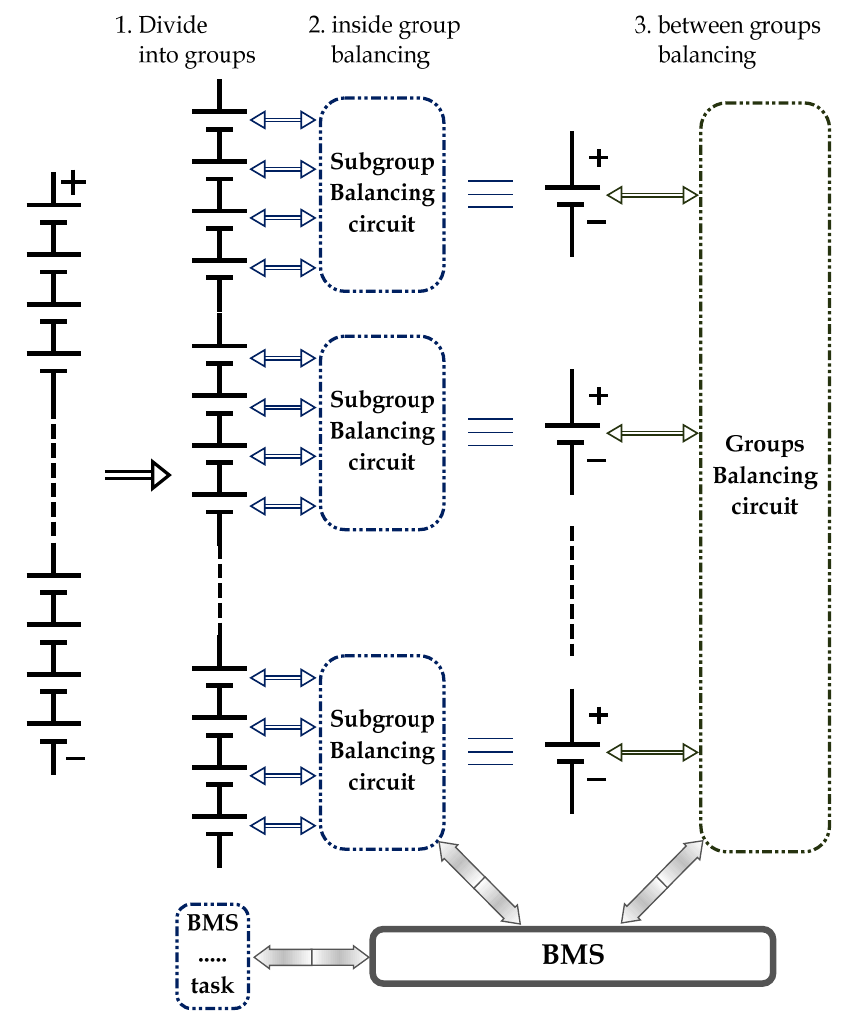
Figure 3. Battery pack balancing based on modularization